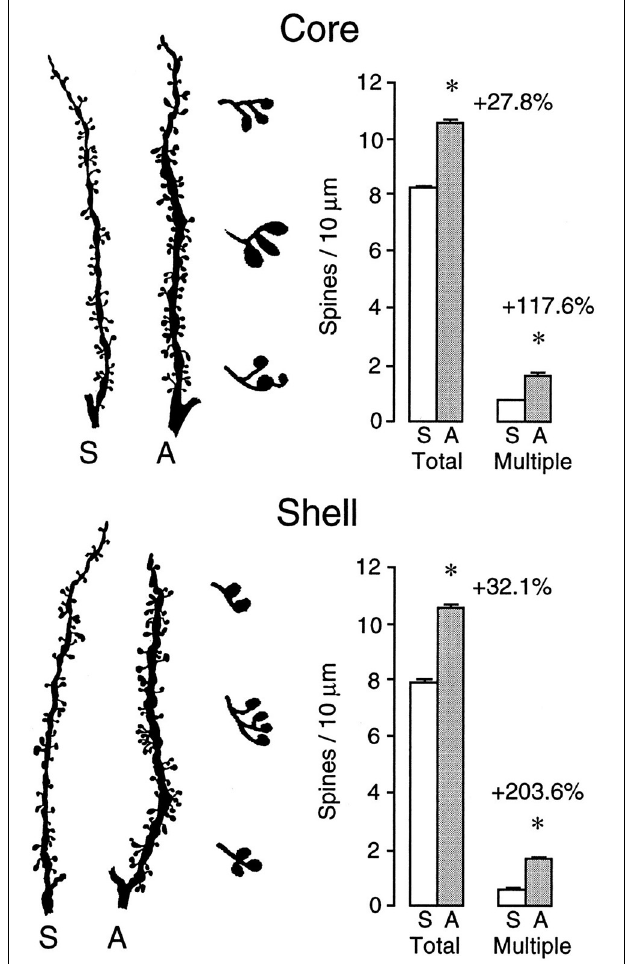
FIGURE 1 | Camera lucida drawings of representative segments from medium spiny neurons in the core (top) and shell (bottom) subregions of the nucleus of saline- or amphetamine-treated rats. The drawings to the right of the segments illustrate multiple heading spines, which show a very large drug-induced increase (After Robinson and Kolb, 1997). ∗ p < 0 .